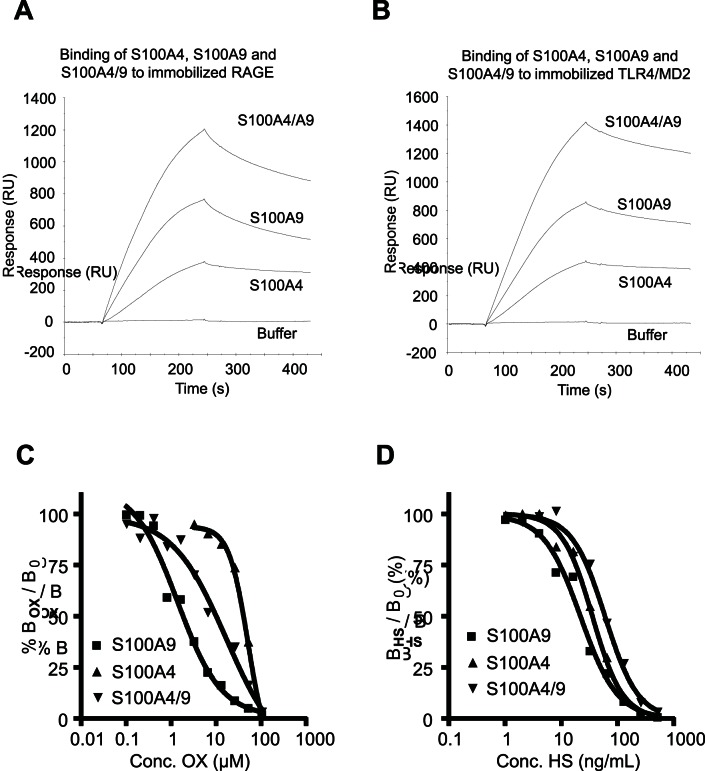
Binding of homo- and hetero-complexes of S100A4 and S100A9 to RAGE are displaced by OX and heparan sulfate (HS).A: Binding of homo- and hetero-complexes of S100A4 and S100A9 to immobilized RAGE and TLR4. S100A4, S100A9 and a 1∶1 mixture of S100A4/9 were injected (2 min at 30 µL/min) over RAGE (left panel) or TLR4 (right panel). B: Inhibition of ∼1.3 µg/mL S100A4, S100A9 and the 1∶1 mixture with 0.195–100 µM OX in the presence of 1 mM Ca++, 20 µM Zn++ and 1% DMSO. Samples were injected (2 min at 30 µL/min) over immobilized RAGE. C: Responses at late dissociation phase (expressed as % of signal in the absence of OX) were plotted against concentration of competitor and IC50 calculated by fit of curves to a sigmoidal dose-response or a one-site competition model. IC50 values of 1.4, 52 and 17 µM were calculated for S100A9, S100A4 and S100A4/S100A9. D: Corresponding experiment with 0.98–500 ng HS/mL as competitor. Conditions were identical except that DMSO was omitted from the sample buffer. HS inhibited binding of S100A9, S100A4 and S100A4/S100A9 to RAGE with 50% at 22, 36 and 60 ng/mL.